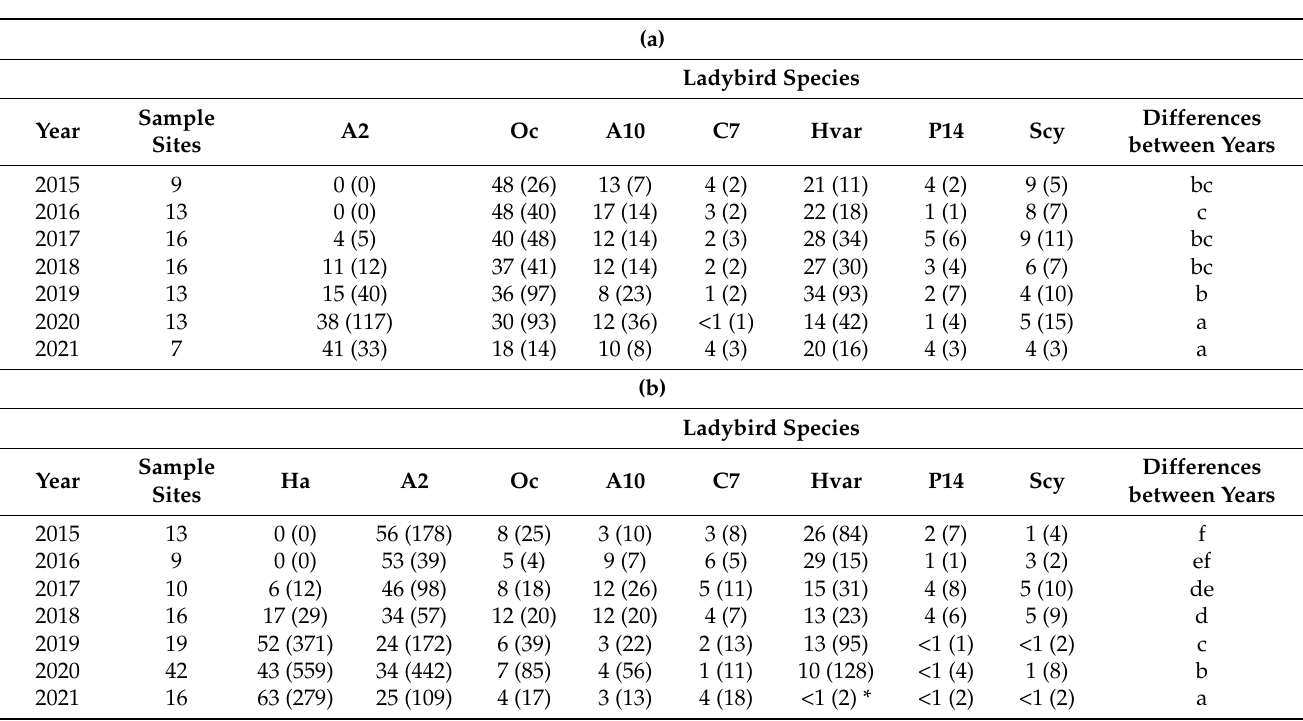
Table 1. Yearly relative (%) and absolute (in parentheses) abundances of the different ladybird species in ( a ) the not yet invaded and ( b ) invaded area (from 2015 to 2021). The ladybird species have been abbreviated as: Ha ( H. axyridis ), A2 ( A. bipunctata ), Oc ( O. conglobata ), A10 ( A. decempunctata ), C7 ( C. septempunctata ), Hvar ( H. variegata ), P14 ( P. quatuordecimpunctata ), and Scy ( Scymnus spp.). Years with different letters in the right-hand column are significantly different at p < 0.05. * See discussion for the reason of the low recorded value.